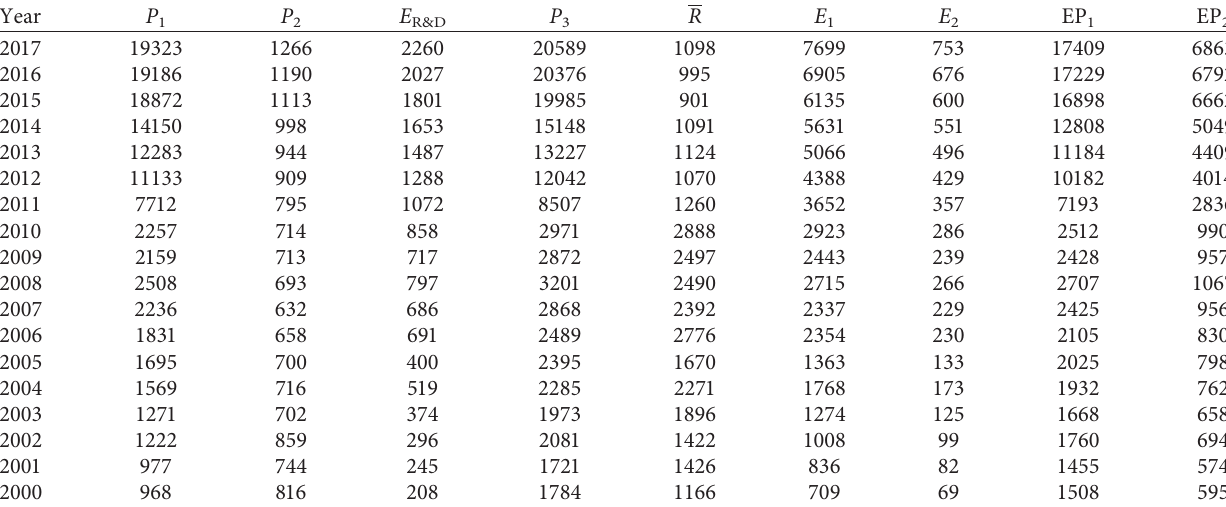
Table 1: Relevant data of empirical